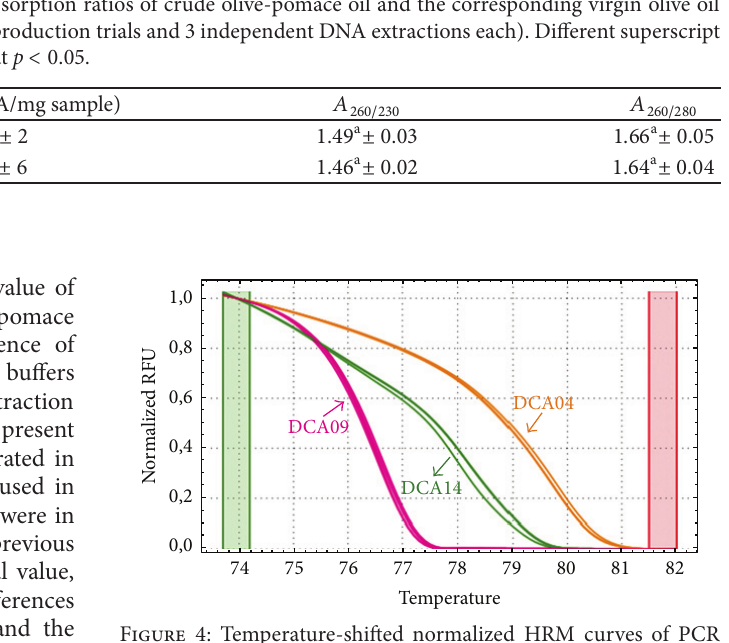
Figure 4: Temperature-shifted normalized HRM curves of PCR products obtained by amplifying DCA04, DCA09, and DCA14 microsatellites in crude olive-pomace oil and in the corresponding virgin olive